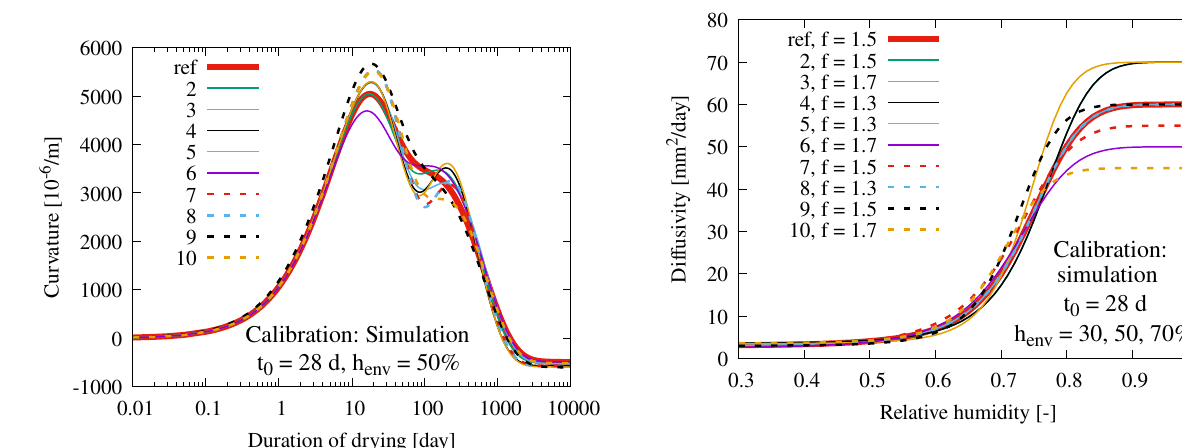
Figure 7. Di ff usivity functions giving the best agree- ment with the axial shrinkage from the reference sim- ulations (symmetric drying at three levels of ambient relative humidity h env = 30 , 50 , 70%, D = 150 mm, t 0 = 28